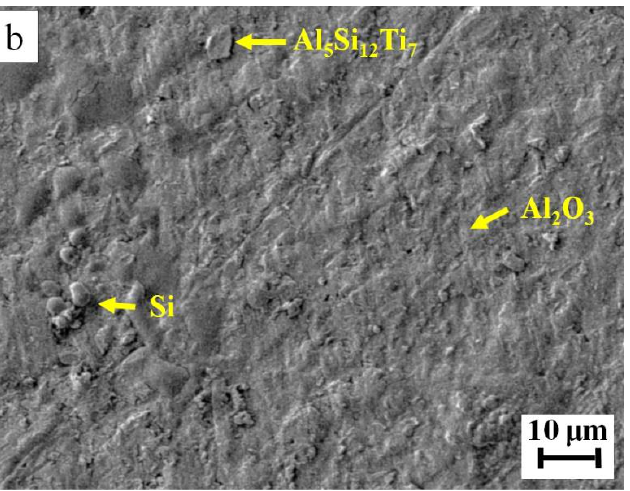
Figure 12. Fractography of the aluminum alloy/alumina joint bonded with the Al10Si10Cu4Ti filler alloy: ( a ) AA6061 side and ( b ) alumina side.